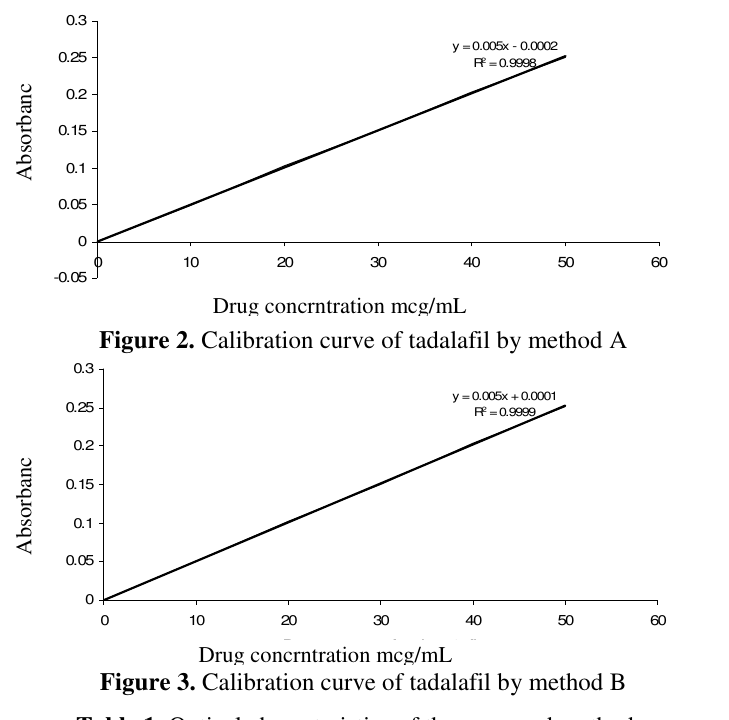
Figure 2. Calibration curve of tadalafil by method A